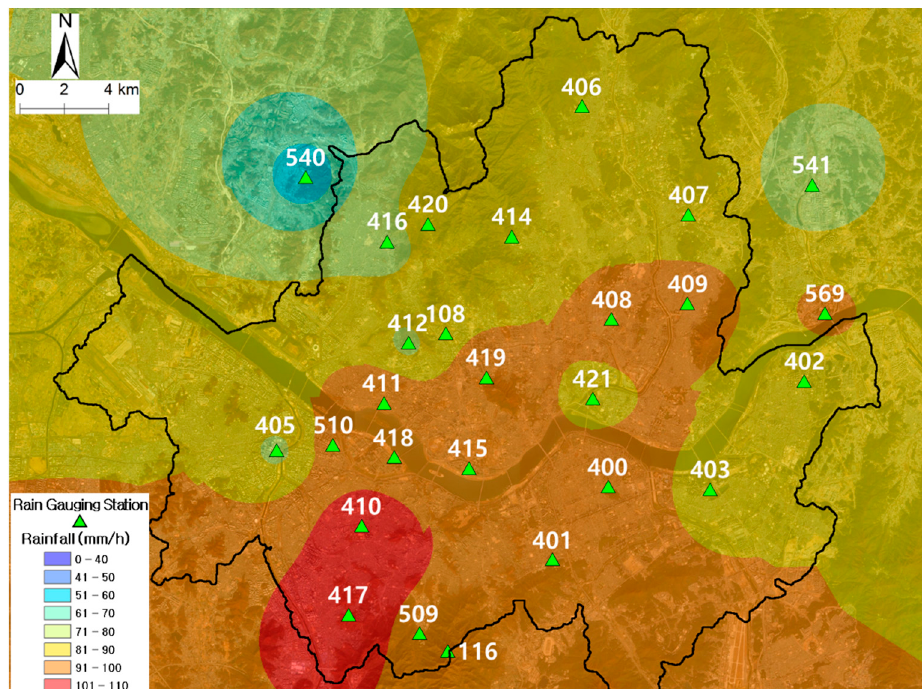
Figure 6. Rainfall interpolation result (2001). Figure 5. Rainfall interpolation result (2001).